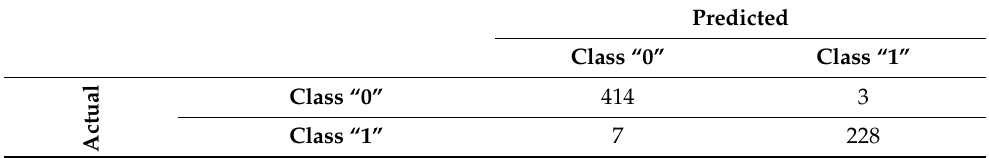
Table 18. Confusion matrix for Random